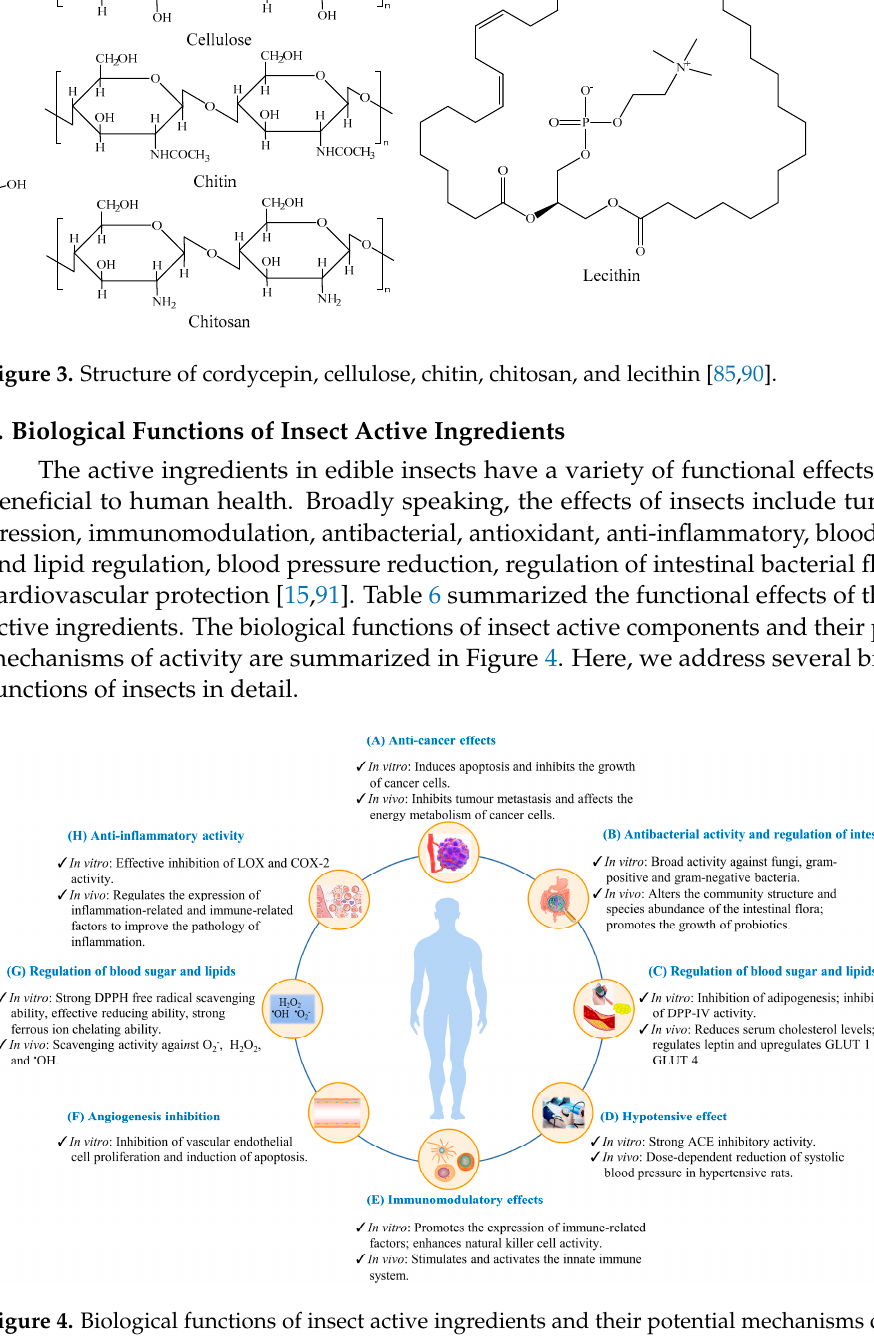
Figure 4. Biological functions of insect active ingredients and their potential mechanisms of